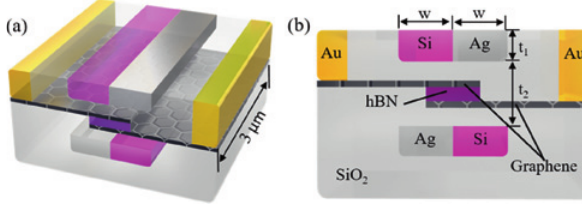
Figure 1: Structure of the GOSM with orthogonal HPWs. (a) Three- dimensional schematic illustration and (b) cross-section of the